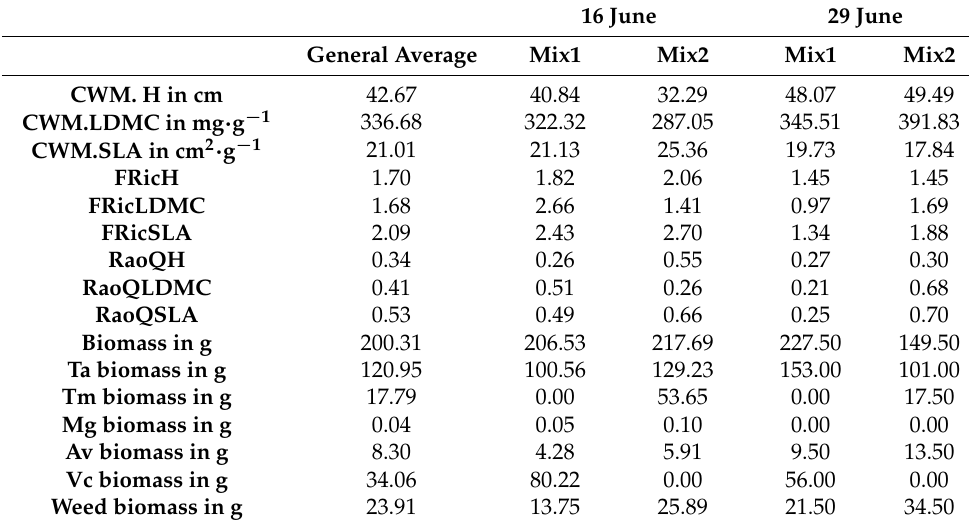
Table 2. Average value of the different vegetation characteristics. This table presents the overall average of the different variables of the vegetation and the average per plot (mix and cutting